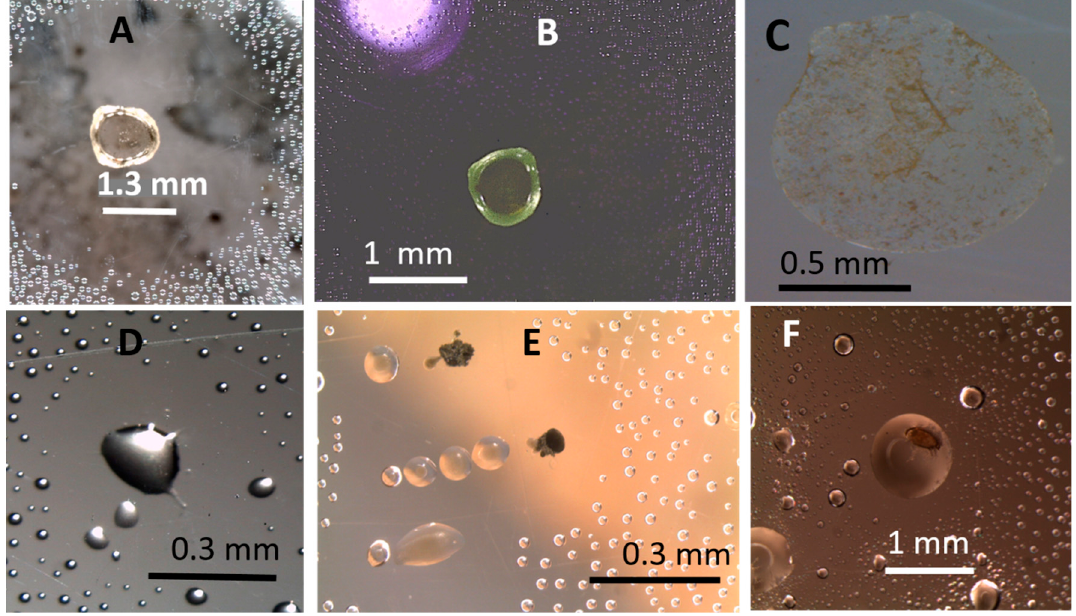
Figure 11. Stereomicroscopic views of water-repelling liquid droplets captured on the inner surface of plastic Petri-plate lids. The lids were covering fungal cultures incubated on malt extract agar for 4 weeks. The upper row shows droplets emitted by Penicillium expansum strain Rcp61. ( A ) and ( B ) show colourless and green fluorescence-emitting exudate droplets when pictured in visible and UV-light, respectively; ( C ) dry substances of a liquid droplet evaporated on the inner surface of the lid; ( D ) and ( E ) show water-repelling nature of the hydrophobic droplets emitted by cultures of Trichoderma atroviride 14/AM after 2 and 6 weeks of incubation, respectively; ( F ) hydrophobic droplet emitted by a 3-months-old Chaetomium globosum MH5 culture containing a dust mite.